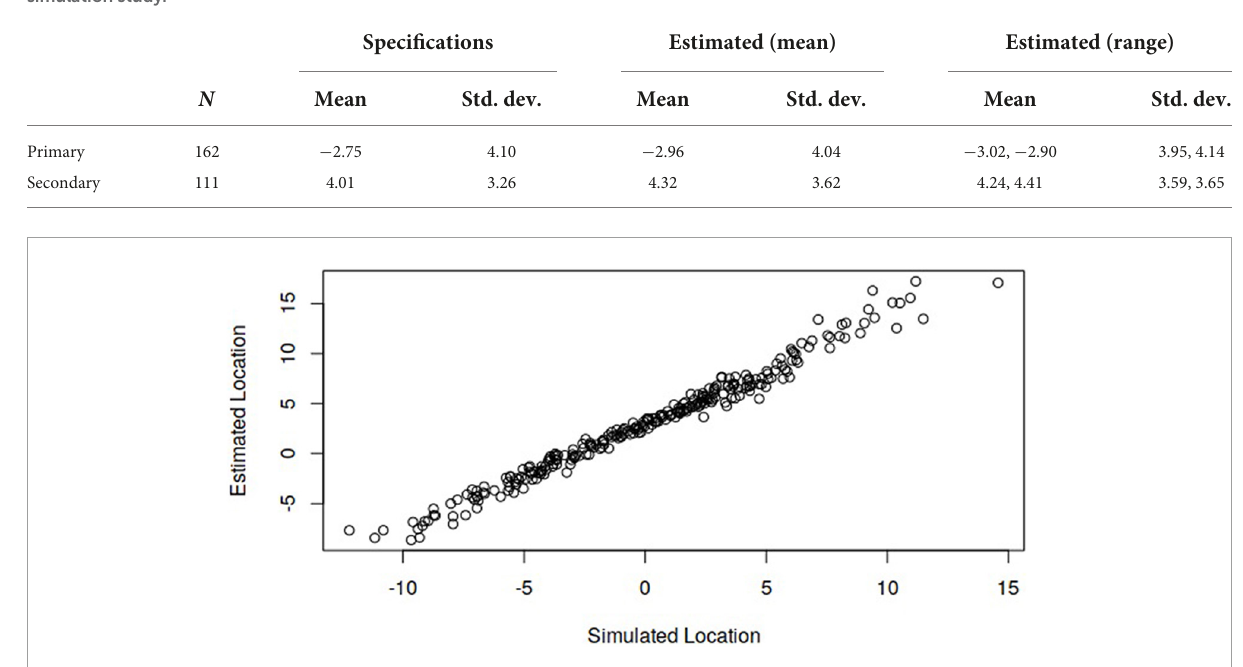
FIGURE5 Simulated locations against estimated locations based on joint scaling of all 273 performances in the simulation study.